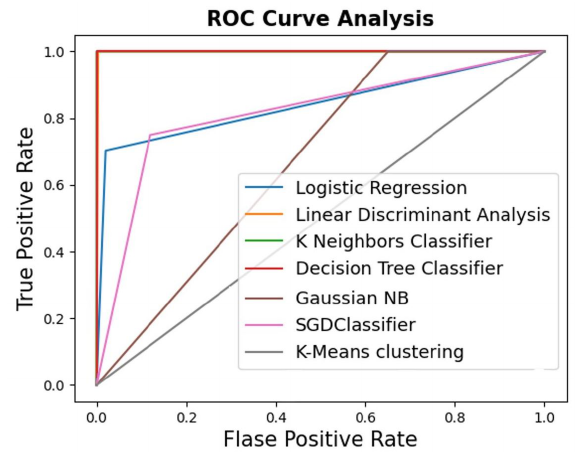
Figure 17. The ROC curves of ML models for Bruteforce.